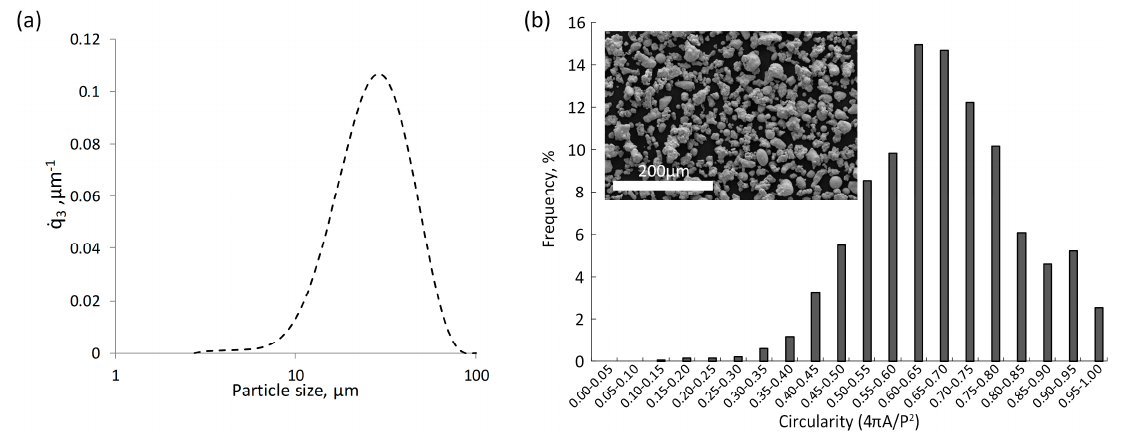
Figure 2. Water-atomized iron powder: ( a ) particles size distribution ( b ) circularity distribution and typical scanning electron microscope (SEM) image.